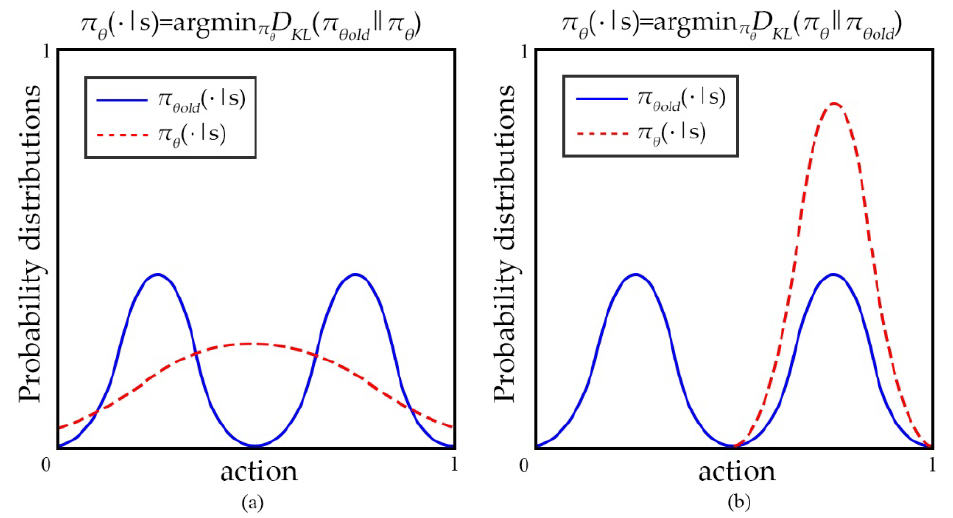
Figure 3. Comparison of forward and reverse KL. ( a ) Forward KL distribution. ( b ) Reverse KL dis- tribution.